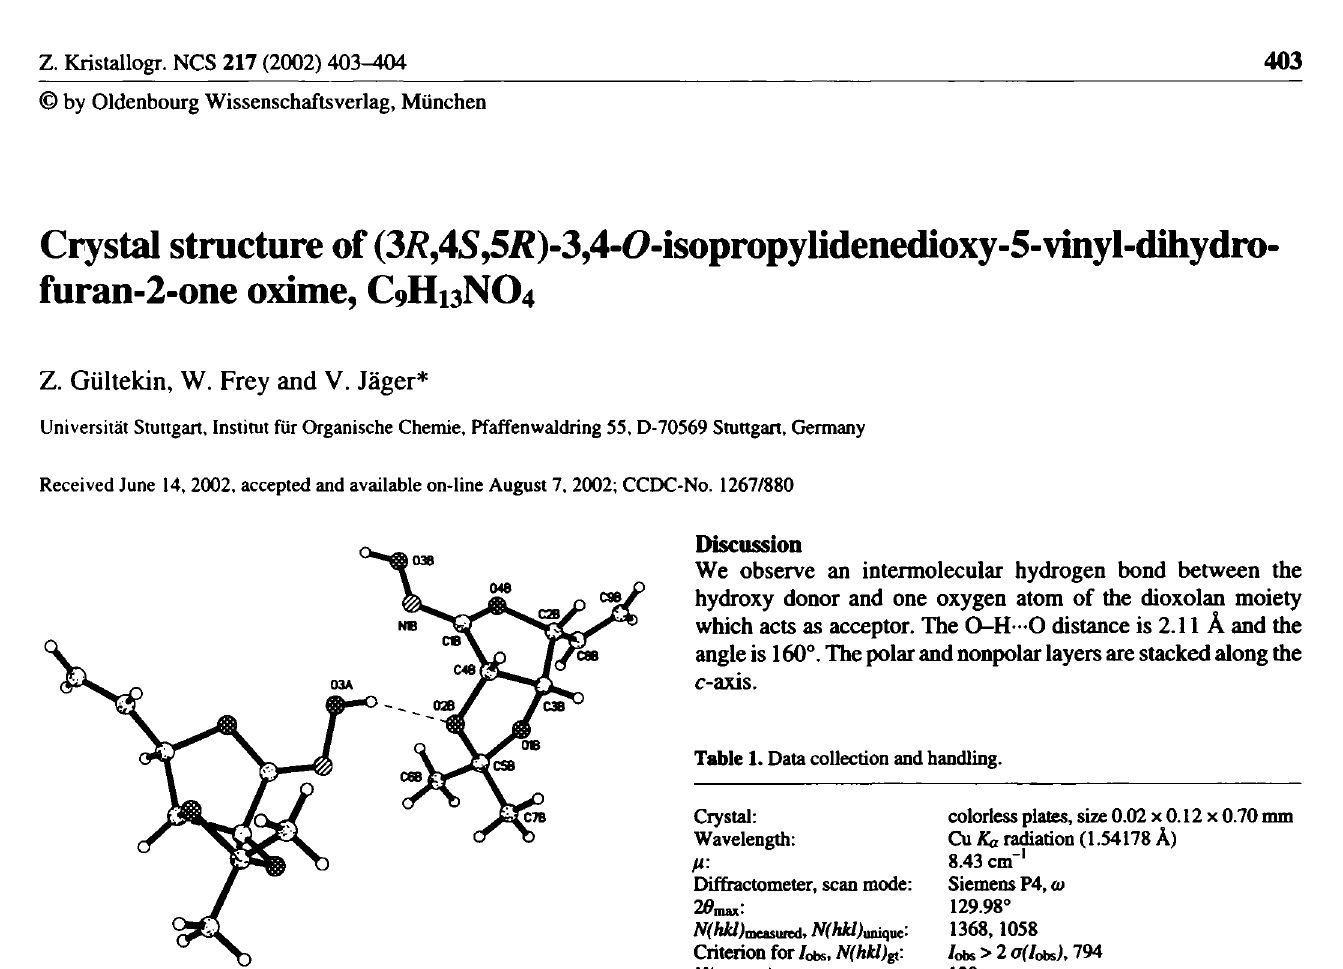
Table 2. Atomic coordinates and displacement parameters (in Â 2 ).